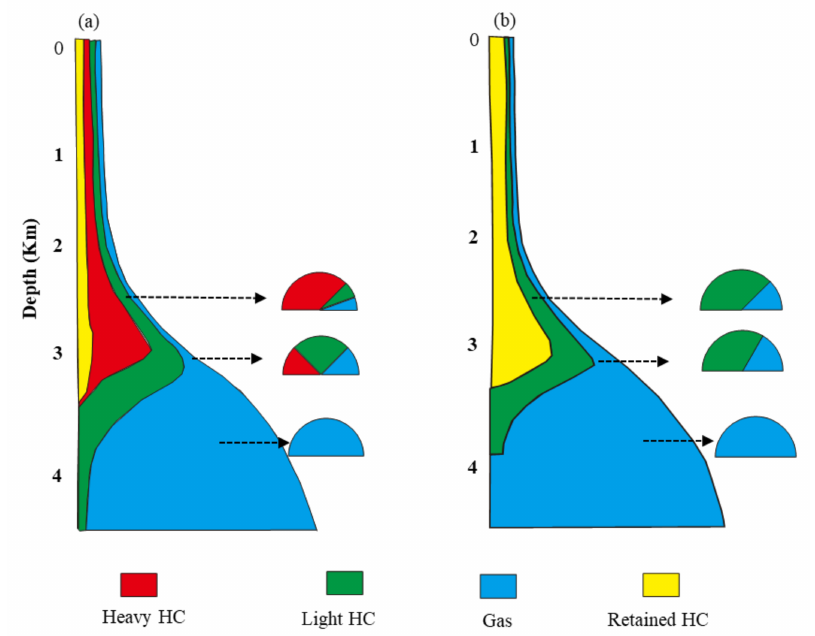
Figure 9. Possible effects of minerals on hydrocarbon pool in nature. ( a ) The left panel tends to minimize the retention effect; ( b ) the right panel tends to maximize the retention